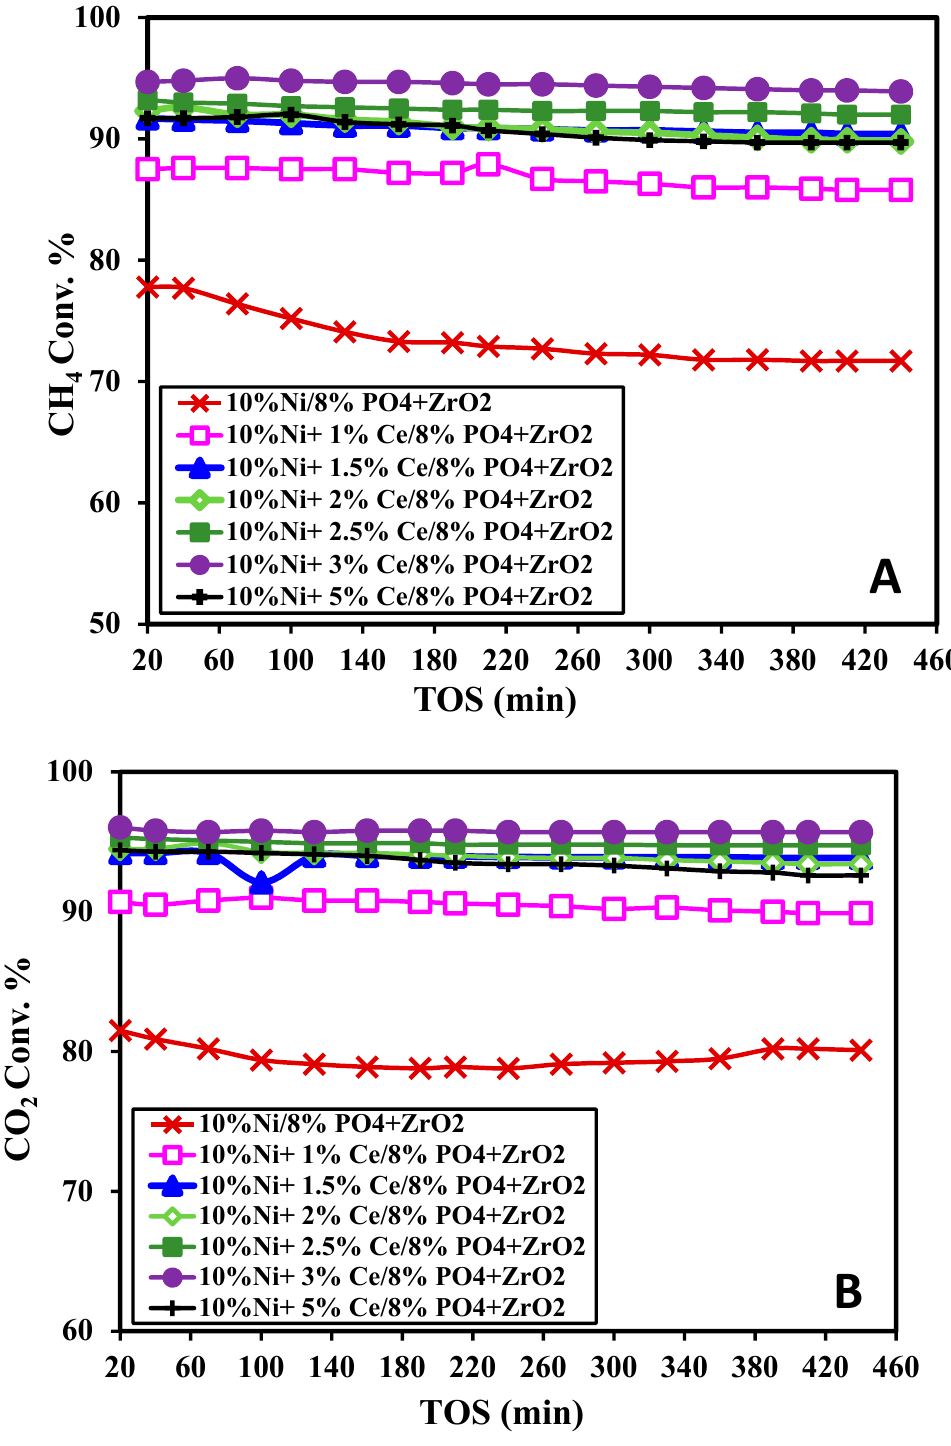
Figure 5. Catalytic activity of 10 Ni + x% Ce / 8% PO 4 + ZO 2 (x = 0, 1, 1.5, 2, 2.5, 3.5, and 5) catalyst calcined at 600 ◦ C, operated at 800 ◦ C, GHSV = 28000 (mL / g / h) ( A ) CH 4 conversion against time-on-stream (TOS) ( B ) CO 2 conversion against TOS.